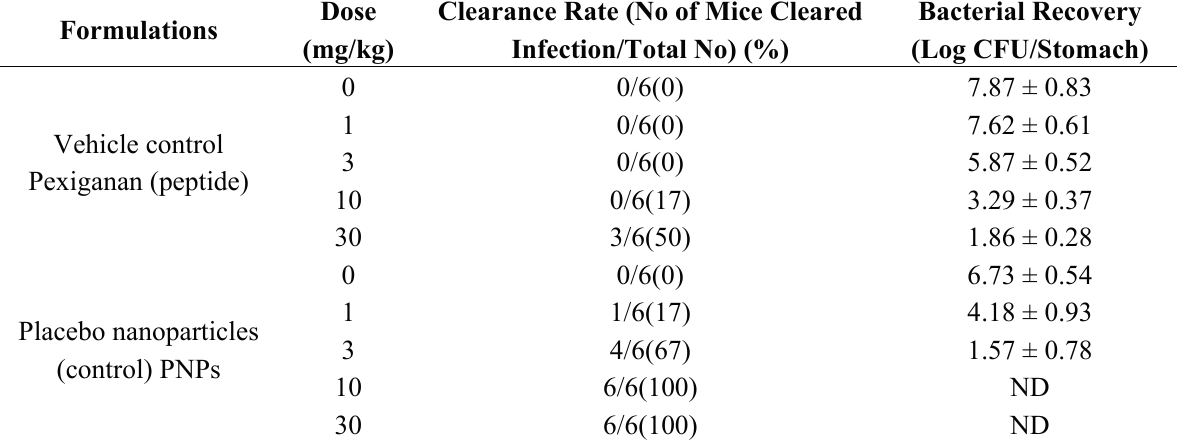
Table 2. Effect of repetitive administration of pexiganan and PNPs against gastric infection caused by H. pylori in